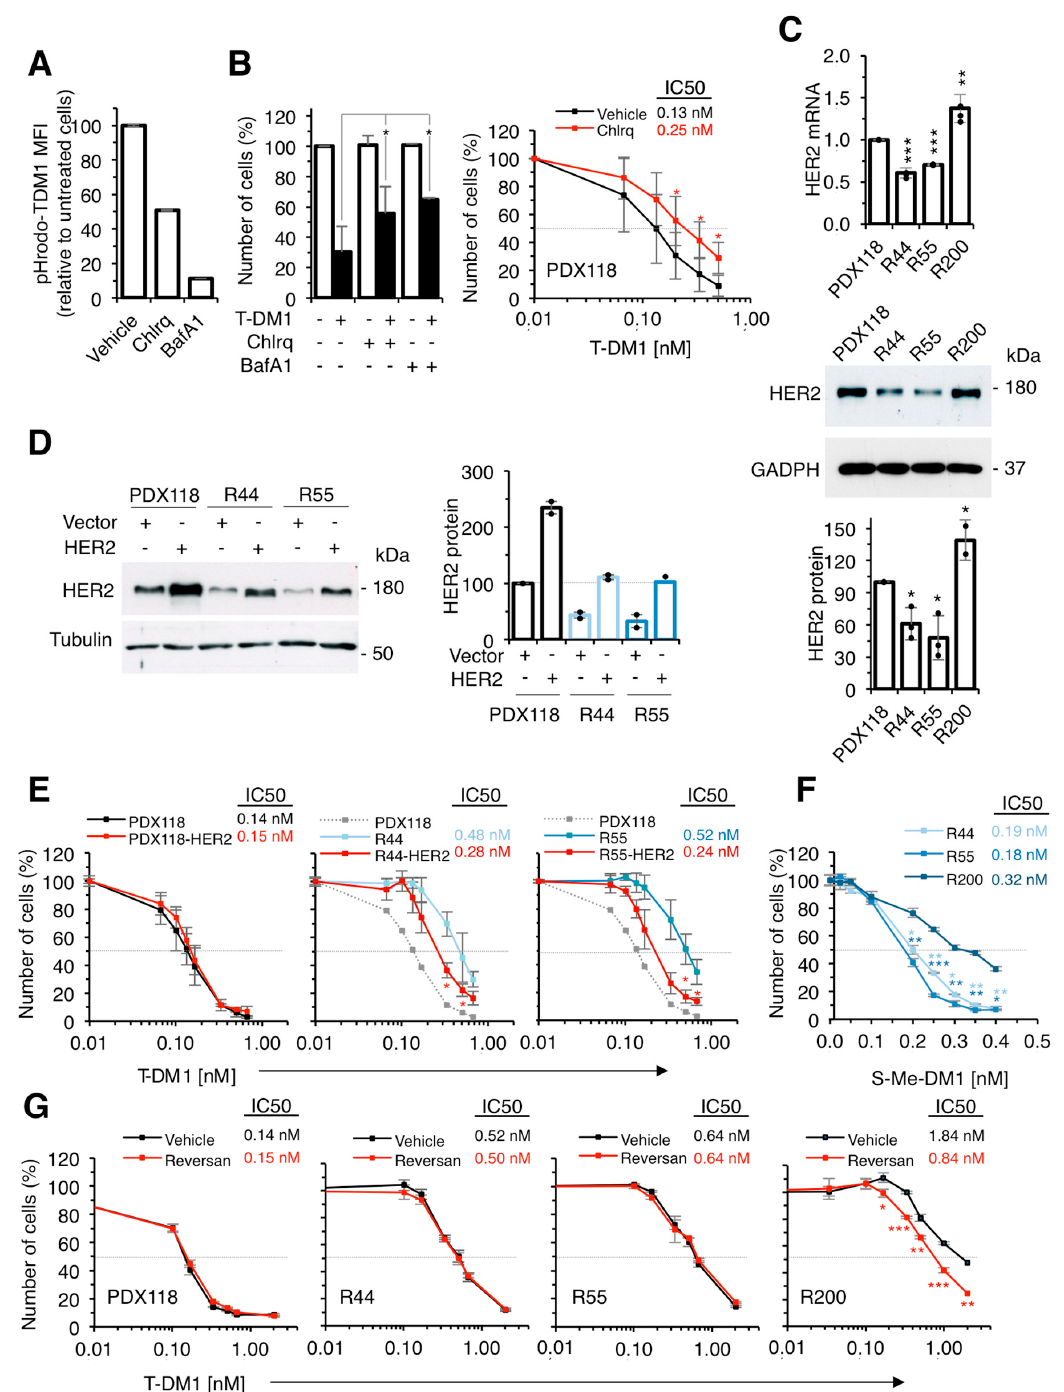
Figure 3. Characterization of in vitro resistant cells. ( A ) Cultures from PDX118 treated with vehicle, Chloroquine (Chlrq) or Bafilomycin A (BafA1) were stained with pHrodo-T-DM1 for 24 h at 37 ◦ C and analyzed by FACS. Results are expressed as a percentage of red-positive cells; ( B ) Left, Cell cultures derived from PDX118 treated with vehicle (-), Chloroquine or Bafilomycin A and T-DM1 as indicated were quantified by crystal violet staining and expressed as percentages relative to cells treated with vehicle. Results are averages and standard deviation of four independent experiments. * p < 0.05, two-tailed Student t test. Right, The same cells were treated with vehicle or Chloroquine and with increasing concentrations of T-DM1. Cell numbers were estimated by crystal violet staining.